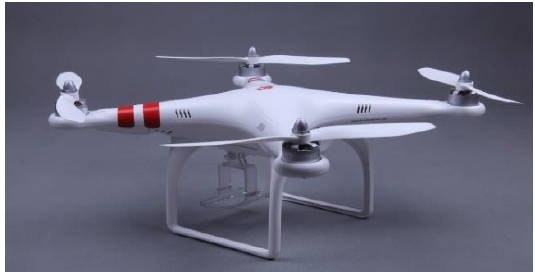
Figure 2. DJI Phantom